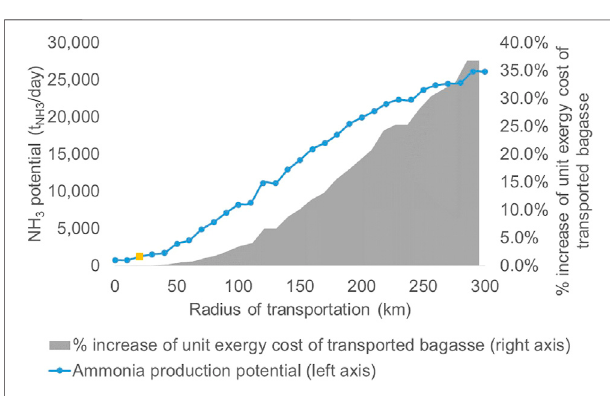
FIGURE 7 | Variation of the ammonia production potential and the unit exergy cost of the transported bagasse as a function of the radius of transportation. Ammonia plant is located in Pradópolis city. The yellow squared point refers to the radius of transportation adopted in this work (20